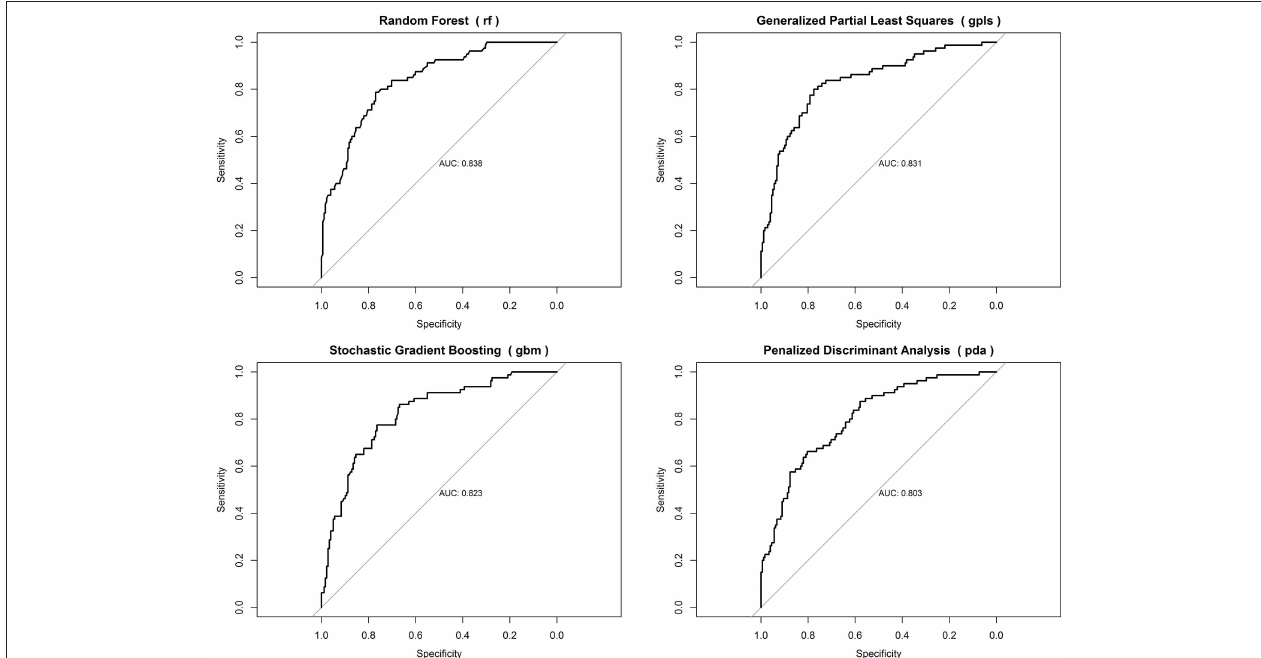
FIGURE 3 | ROC curves for best-performing predictive models for in-hospital mortality.